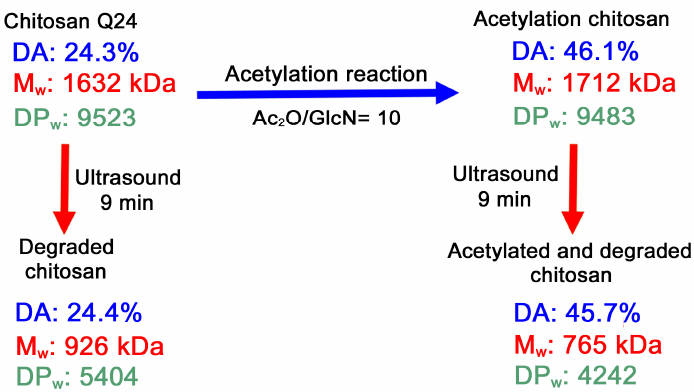
Figure 12. Chitosan Q24 acetylation and degradation scheme.